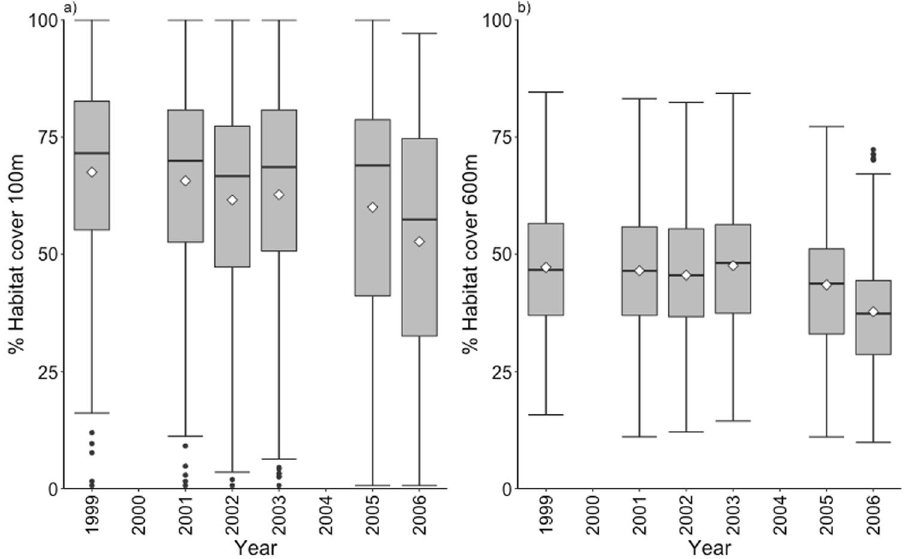
Figure 2. Box plots showing change in habitat cover at the territory core (100 m) ( a ) and landscape (600 m) ( b ) scales during the study period of eight years. The box plots show raw data of percent cover of habitat (old forest) of nest box sites for each year separately. The tops and bottoms of the grey boxes represent the 75 th and 25 th percentiles, respectively, while the lines in the middle of the grey boxes represent the median and the white diamonds show the mean. The whiskers above and below the grey boxes represent 1.5 times the inter-quartile range, and the individual points represent values beyond